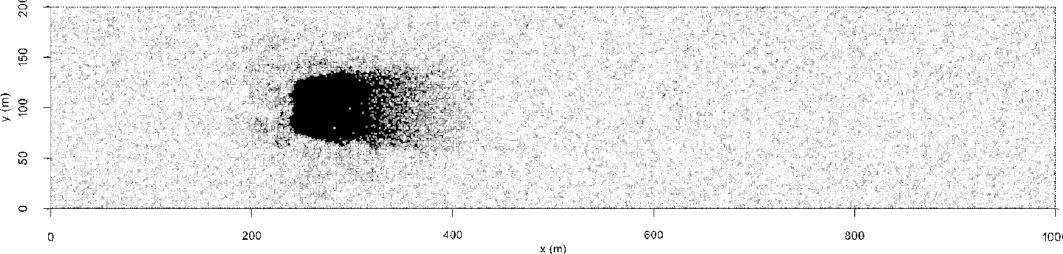
Figure 12. Horizontal slice at hub height through the mesh for the dual rotors only case. Mesh resolution increases sharply toward the rotors and reduces gradually downstream to the resolution used in the empty channel